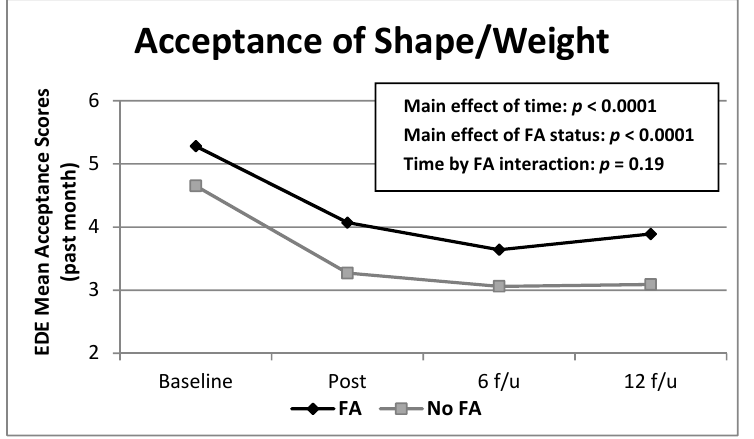
Figure 2. Frequencies of EDE Acceptance of shape/weight scores over time by food addiction group. Note: Means were derived from raw data for ease of interpretation. EDE = Eating Disorder Examination; FA = food addiction. Acceptance = shape/weight acceptance during the past 28 days. Significant main effects were found for food addiction ( p < 0.0001) and time ( p < 0.0001). All follow-up scores were significantly different from baseline. Lower scores reflect greater acceptance of shape/weight.